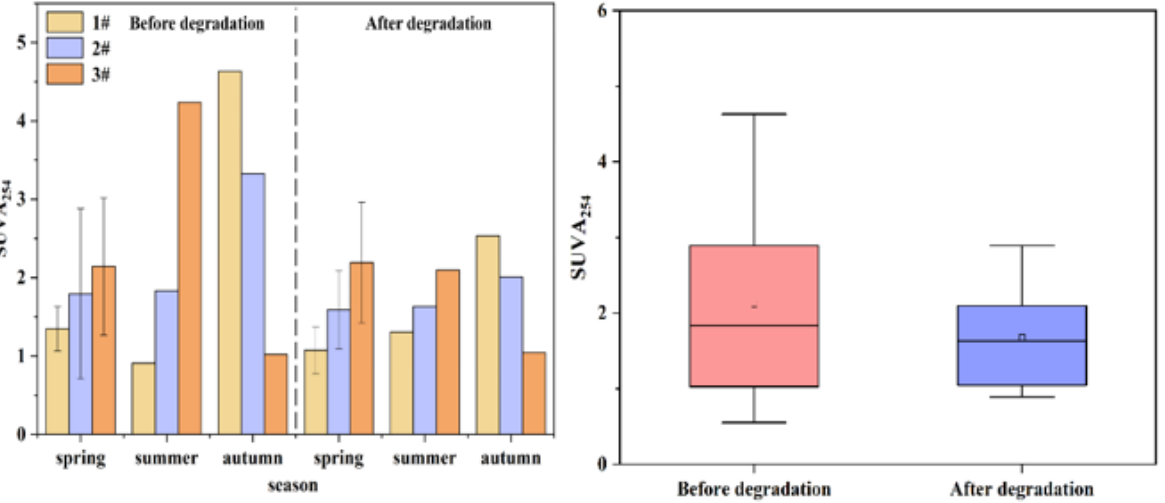
Figure 4. Temporal and spatial changes of SUVA 254 of the Shili River before and after degradation. Right panel: The box-plot consists of five numerical points, minimum observation (bottom edge), 25% quantile (Q1), median, 75% quantile (Q3), and maximum observation (top edge).